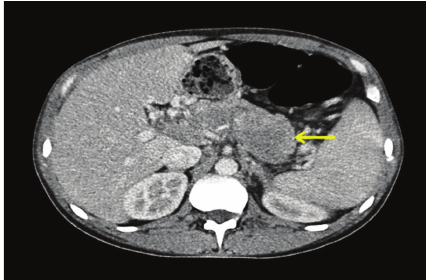
Figure 2: Contrast-enhanced computed tomography at the level of pancreas. Arrow demonstrates multiple peripancreatic soft tissue masses posterior to the pancreatic